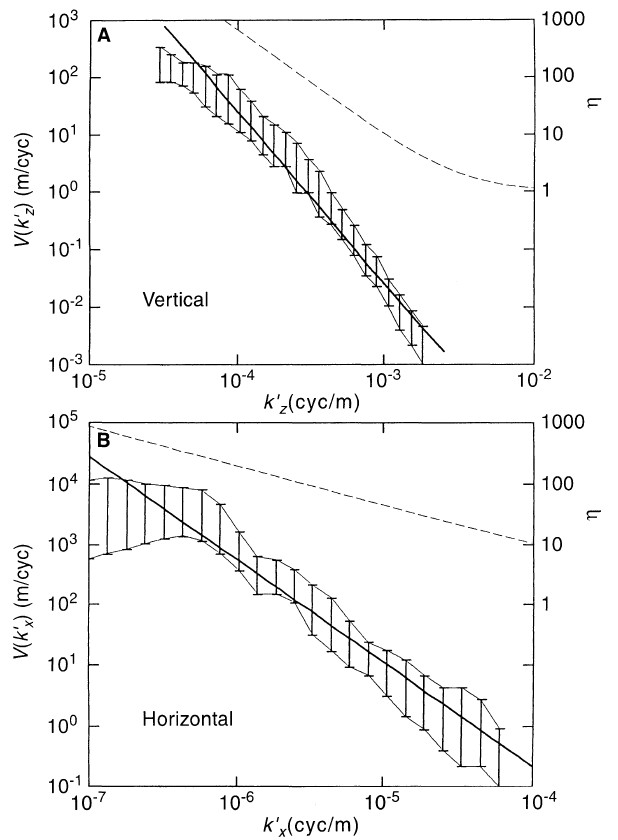
Fig. 7. The comparison of the model ( thick, solid lines ) with the measurements (Hostetler and Gardner, 1994) ( hatched stripes ) of vertical V (cid:133) k 0 (cid:134) ( top ) and horizontal V (cid:133) k 0 (cid:134) ( bottom ) spectra of relative z x fluctuations of temperature (cid:133) T (cid:255) h T i(cid:134) = h T i in the mesosphere at altitudes 80 (cid:4) 100km., k 0 (cid:136) k z = 2 (cid:112) ; k 0 (cid:136) k x = 2 (cid:112) . The numbers on the z x right-hand side are the scale for the anisotropy coe(cid:129)cient (cid:103) (